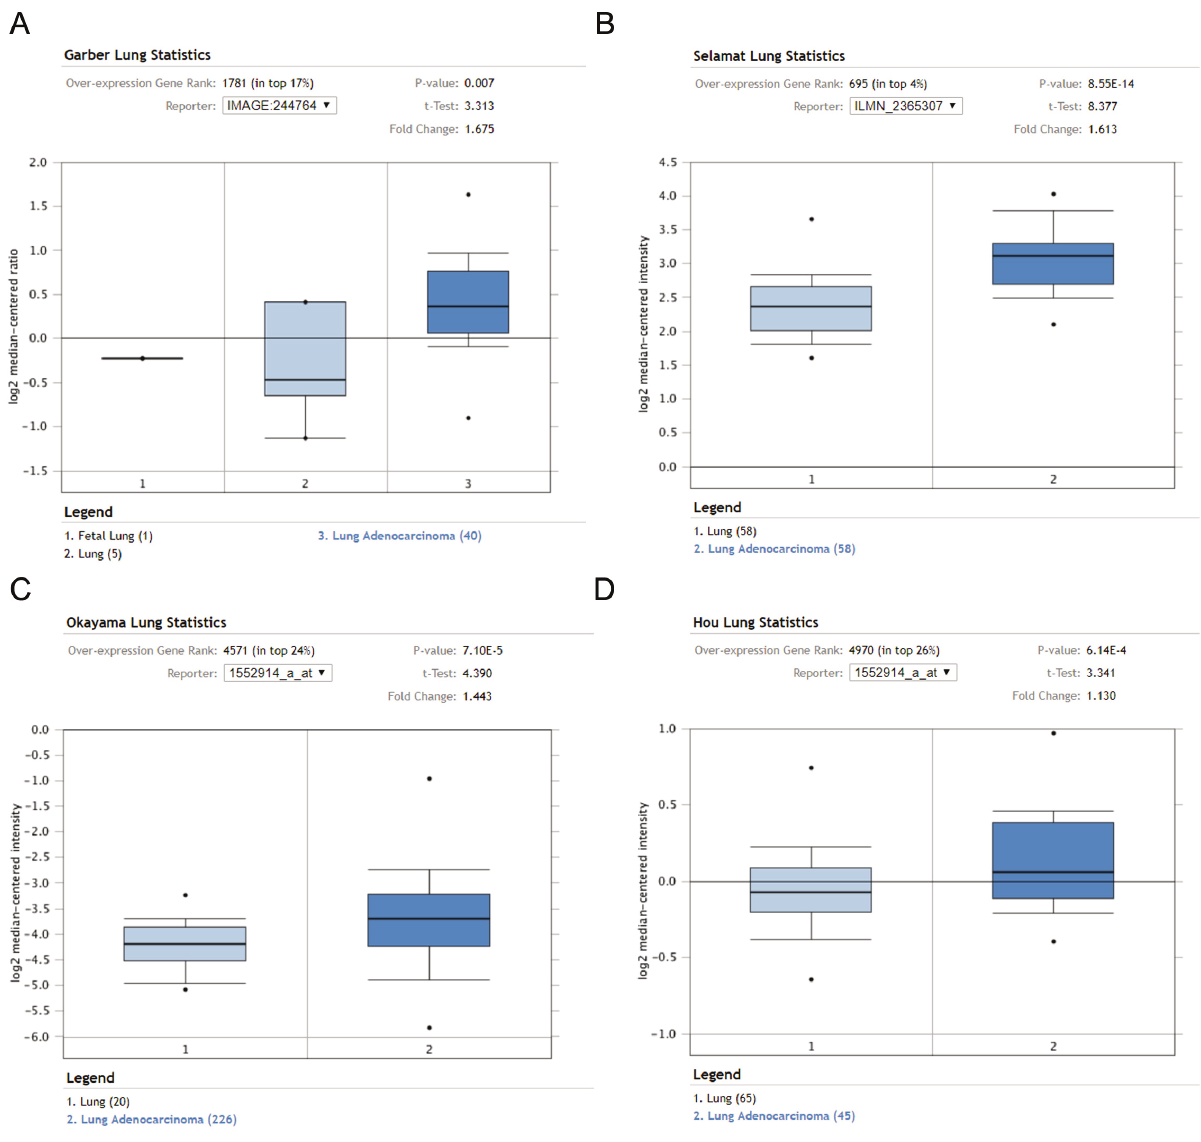
Figure 4: Differential expression of CD276 in NSCLC and normal lung